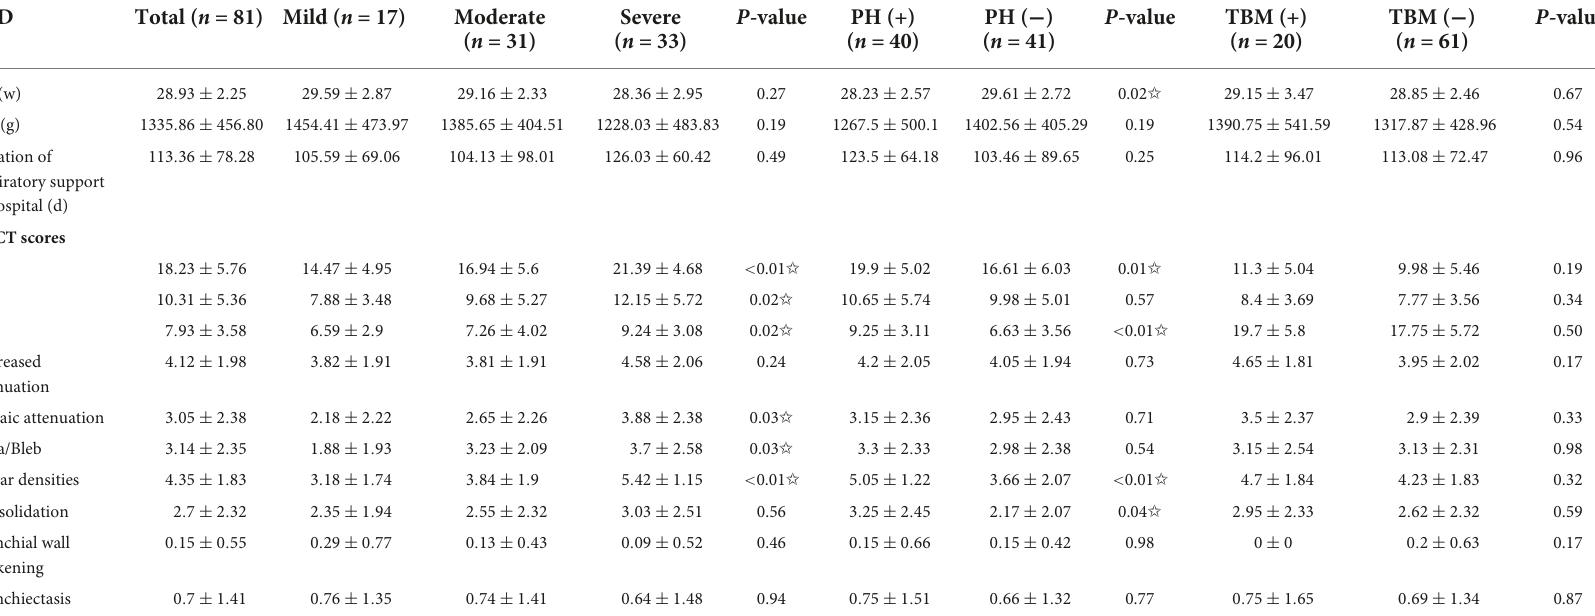
TABLE 2 High-resolution computed tomography (HRCT) scores of subgroups with different